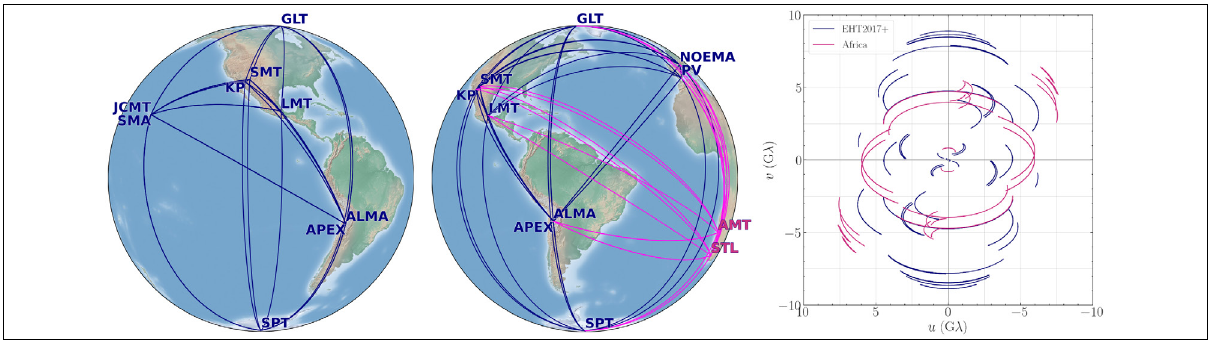
Figure 3: Snapshot of a general relativistic magneto-hydrodynamical simulation of M87 15 (left). Image reconstructed using the 2017 EHT array (middle). Image reconstructed using the proposed ngEHT array at both 230 and 345 GHz (right) recovering both the ring and the jet with far superior contrast and fidelity.